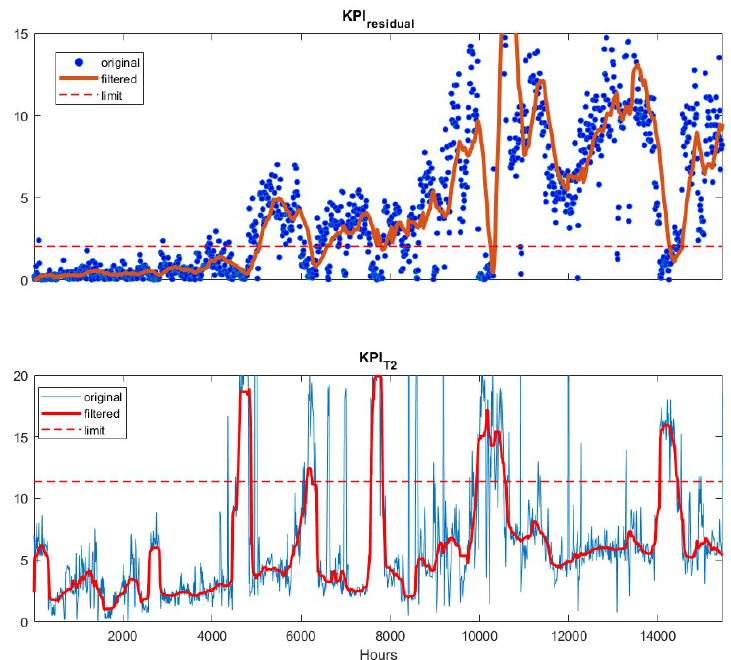
Figure 3. Residual-based KPI (upper) and T 2 -based KPI (lower) for static software sensor without adaptation, applied to the testing data. The raw KPI values ( ● / ─ ), the filtered values ( ─ ) and the upper limits (--) are depicted as well.